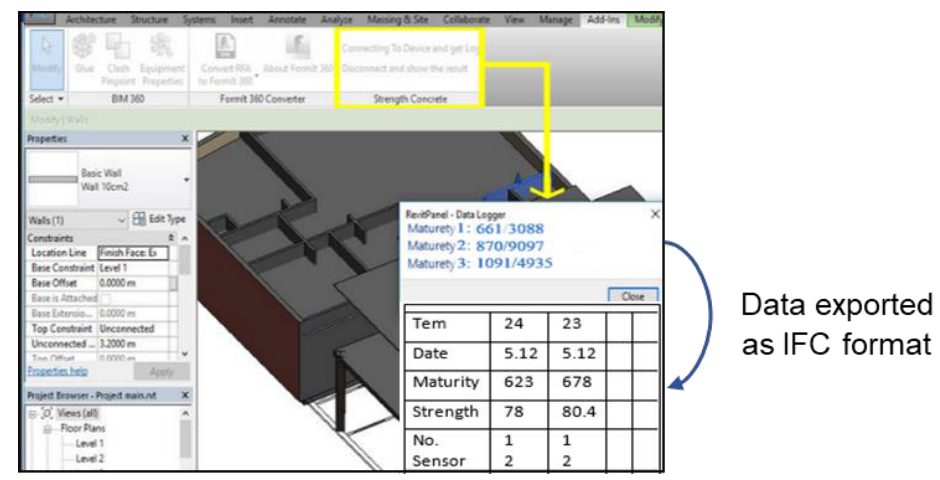
Figure 6. Schematic of BIM interoperability for concrete maturity monitoring.